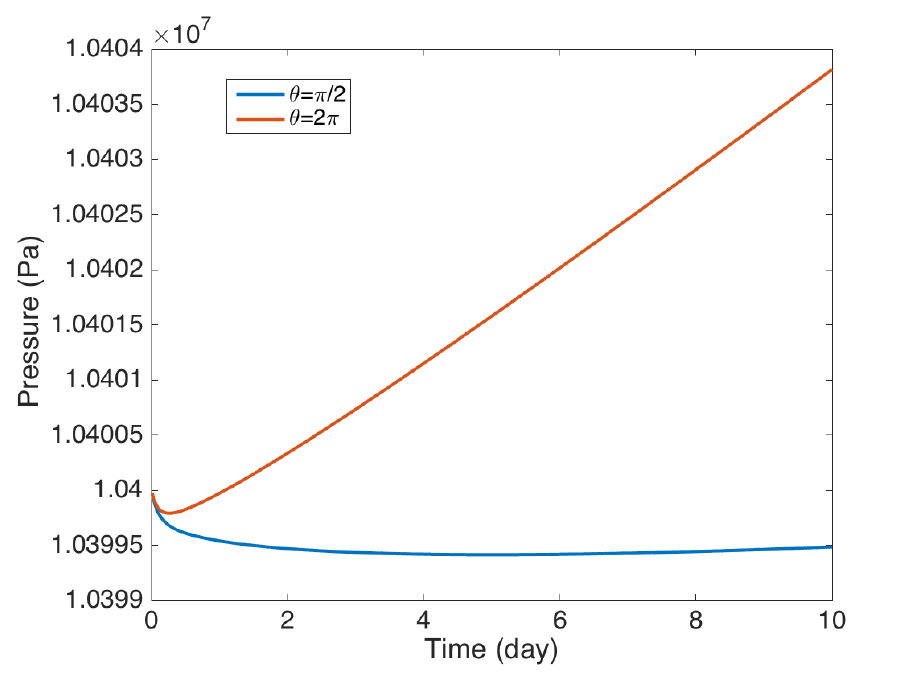
Figure 13. The average pressure for various values of the parameter θ